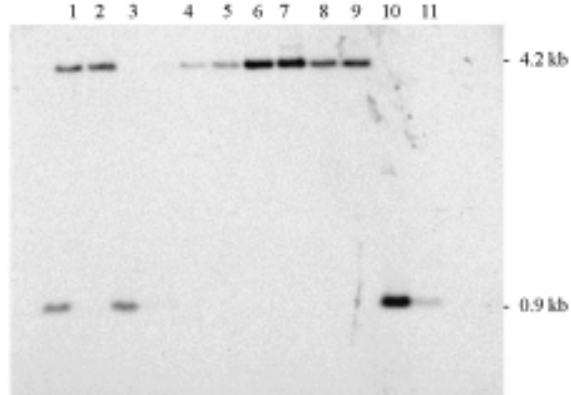
Figure 1 - Southern blotting methylation assay for PWS/AS. Lane 1: nor- mal control; lane 2: PWS control; lane 3: AS control; lanes 4-9: PWS pa- tients; lanes 10-11: AS